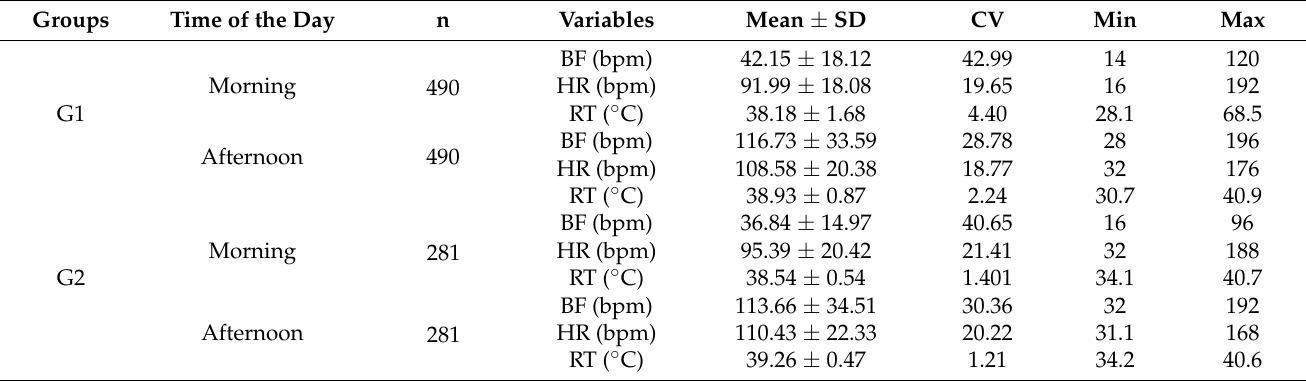
Table 3. Physiological constants of heat-stressed ewes during summer in a tropical region.